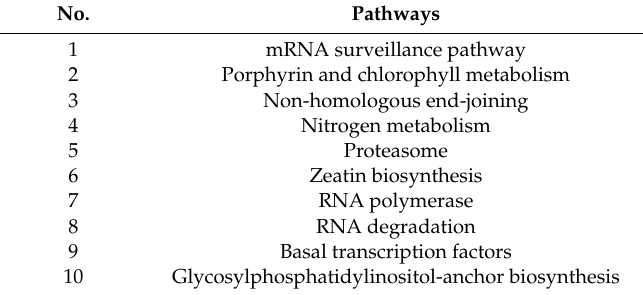
Table 1. The enriched pathways induced by brassinolide priming under drought conditions. No. Pathways 1 mRNA surveillance